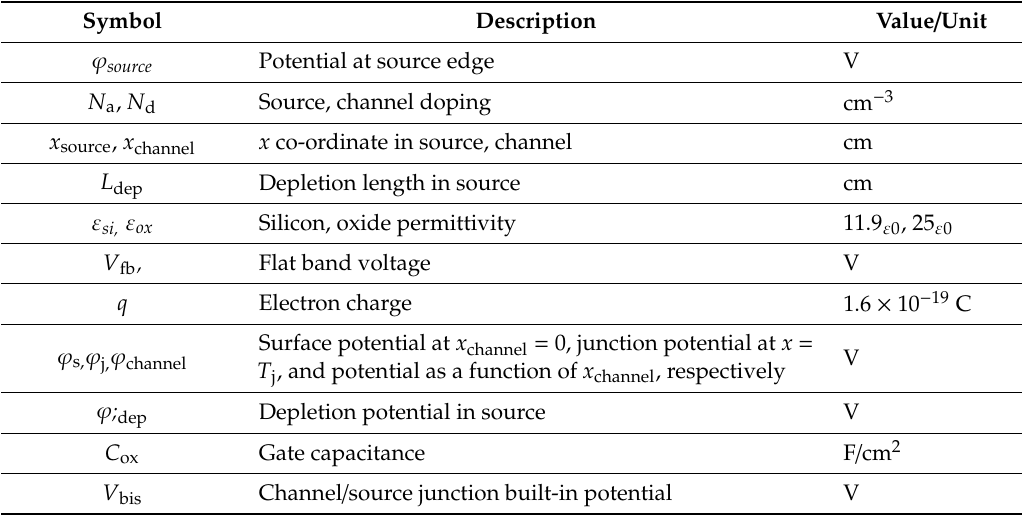
Table 2. List of symbols specifically used in